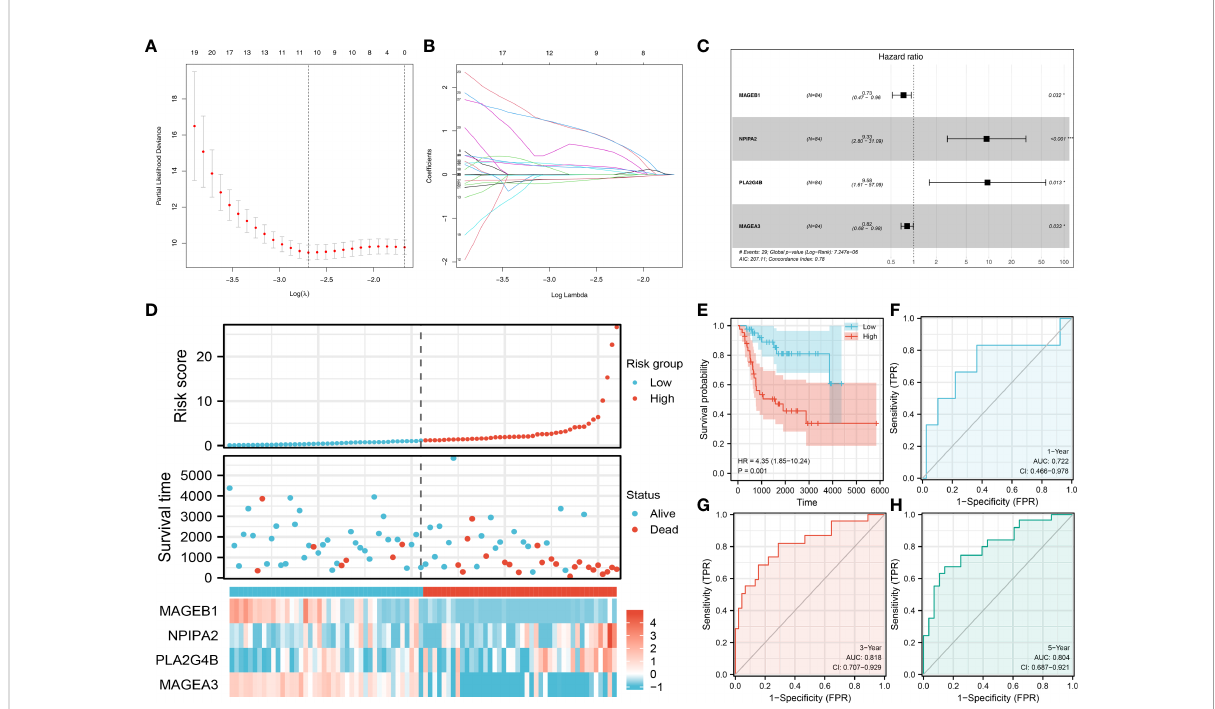
FIGURE 5 Prognosis model construction Notes: (A, B) : LASSO regression analysis was used for dimensionality reduction; (C) : Multivariate Cox regression analysis identi fi ed four genes for model construction, including MAGEB1, NPIPA2, PLA2G4B and MAGEA3; (D) : The overview of the prognosis model; (E) Kaplan-Meier survival curve of overall survival between high and low risk patients; (F – H) : ROC curves of 1-, 3-, 5-years overall